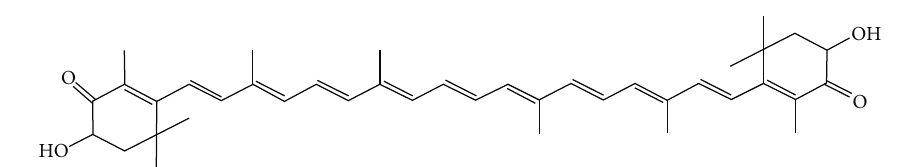
Figure 1: Chemical structure of astaxanthin.